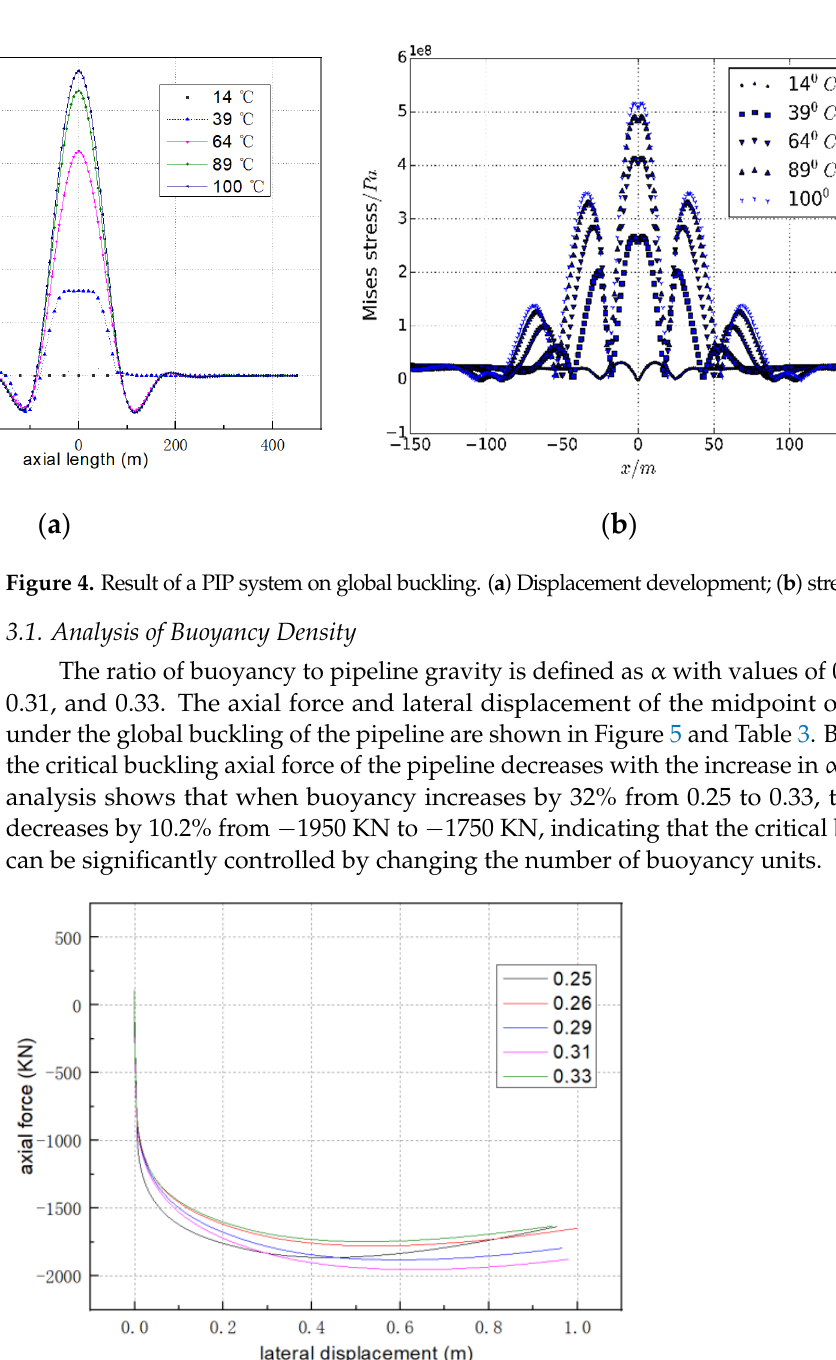
Figure 4. Result of a PIP system on global buckling. ( a ) Displacement development; ( b ) stress development.